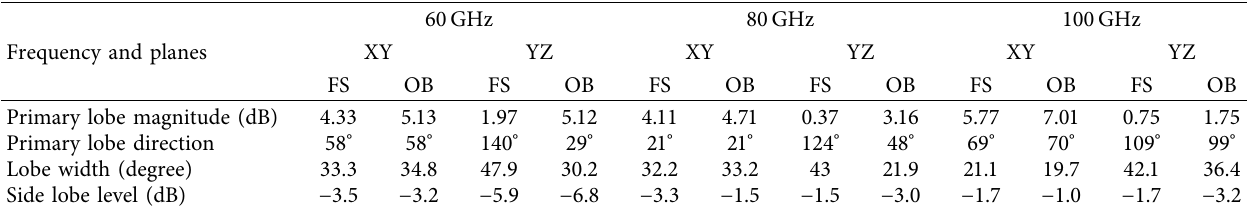
Table 4: Comparison of polar plot radiation patterns at different angles: lobe-wise (FS, free space and OB, on-body). Frequency and